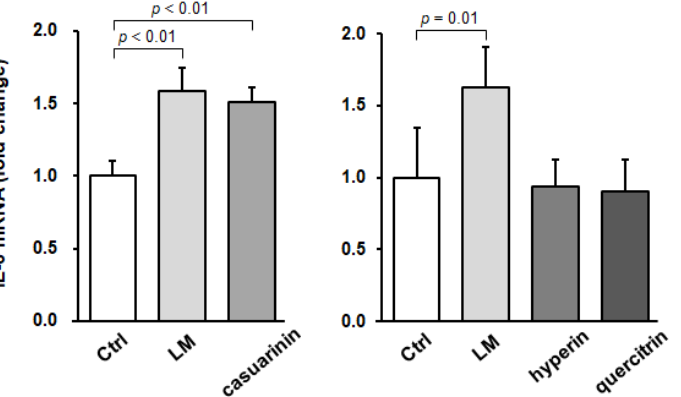
Figure 5. LM and casuarinin upregulate IL-6 mRNA expression in SCs in vitro. SCs were treated with LM (2.5 µg/mL), casuarinin (330 nM), hyperin (220 nM), or quercitrin (220 nM) for 16 h and IL-6 mRNA expression levels were quantified and normalized to GAPDH . Data are shown as fold changes versus Ctrl and represent the mean ± SD of four independent cultures. Significant differences ( p < 0.05) relative to the Ctrl are indicated in the figure, and non-significant differences ( p > 0.05) are not shown in the figure.